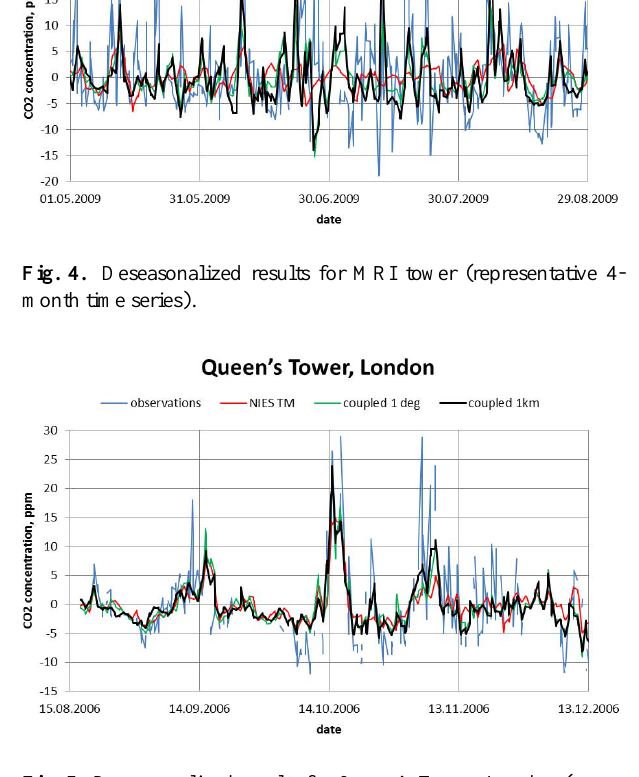
Fig. 5. Deseasonalized results for Queen’s Tower, London (repre- sentative 4-month time